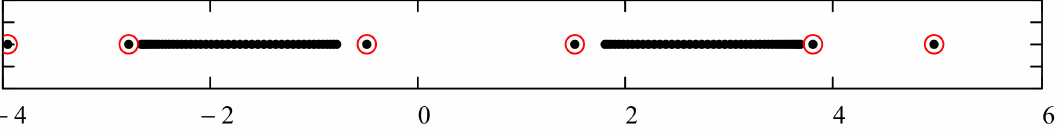
Figure A12. The zeros of P N ( E ) in units of λ 2 for N = 100. We took α = 1.5, β = 2.3 and γ = 3.7. Out of the six isolated eigenvalues (shown with red circles) only E = 3 λ 2 /2 pass the asymptotic test (2.iii) and corresponds to a bound